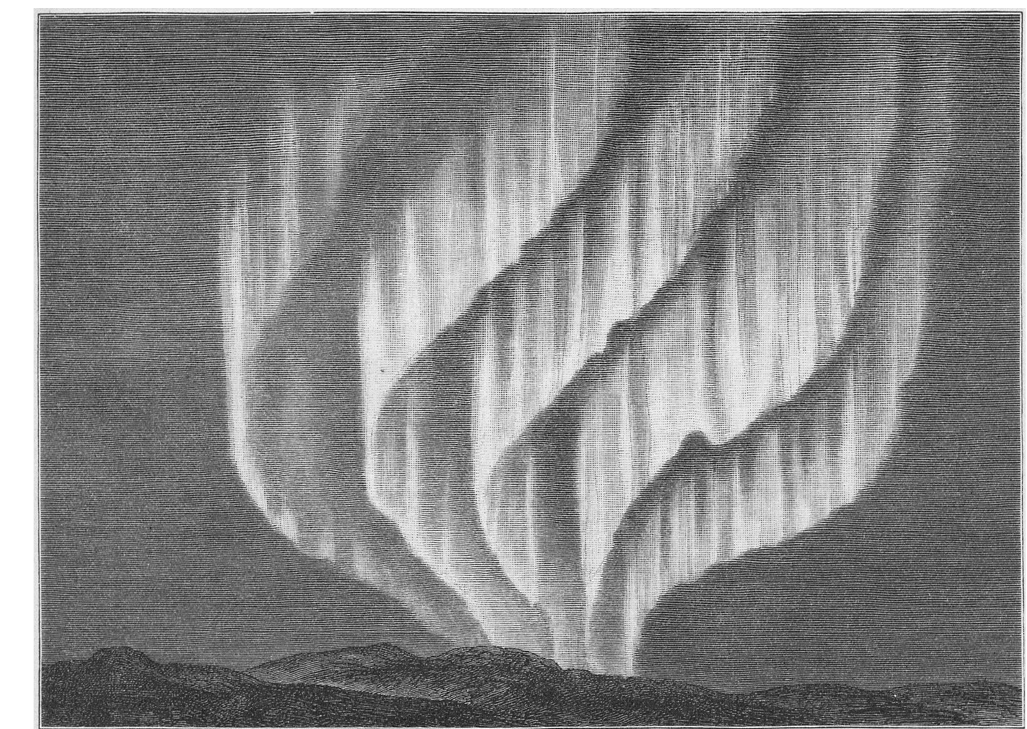
Figure 13. Auroras (multiple rayed bands) observed to South-West from Godthaab on 15 November 1882 at 00h 30m (drawing, Paulsen, 1893a).